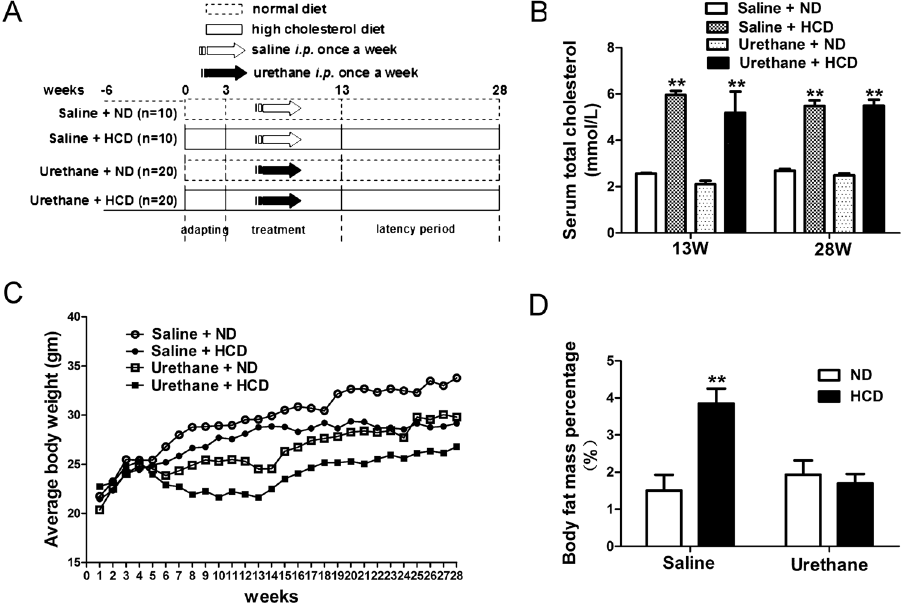
Figure 1. Differences of whole serum total cholesterol level, body weight and fat mass among study groups. ( A ) Schematic diagram of the experimental design for multiple urethane injections induced lung carcinogenesis model in C57BL/6J mice. ( B ) Serum total cholesterol levels analyzed using biochemical autoanalyzer at experimental week 13 and week 28 (n = 5 per group). Column, mean; bar, SEM. ( C ) Body weights of mice measured once a week (n = 10 per group). Dots indicate weight mean per group. ( D ) Quantification of whole body fat mass measured by NMR at experimental week 28 (n = 3 per group). Column, mean; bar, SEM. ** P < 0.01 compared to ND fed mice with the same treatment. NMR: nuclear magnetic resonance; SEM: standard error of